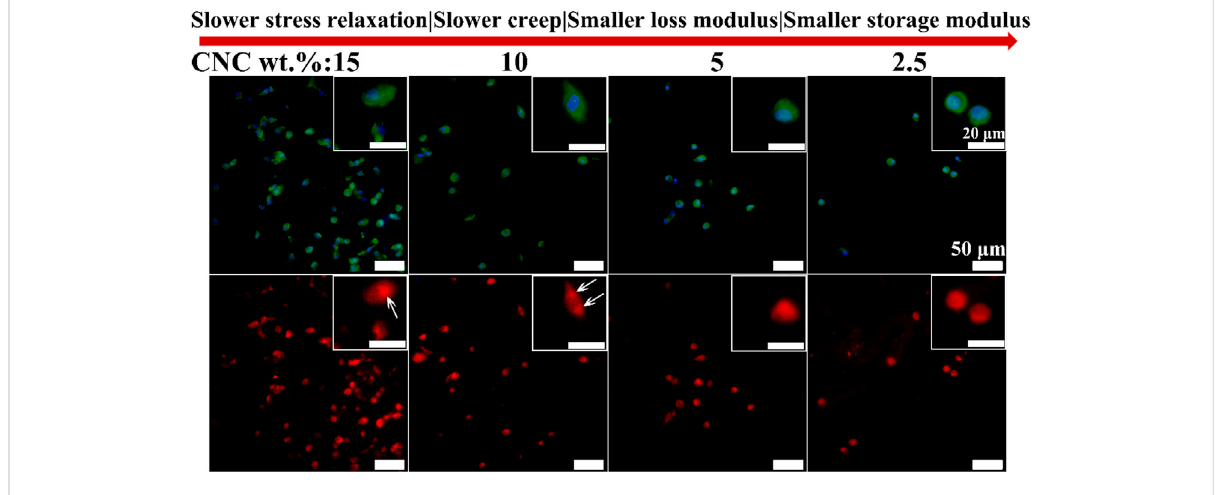
FIGURE 8 YAP staining of chondrocytes cultured in different viscoelastic hydrogels. Green represents actin staining, blue represents nucleus, and red represents YAP. White arrow indicates the location of YAP.